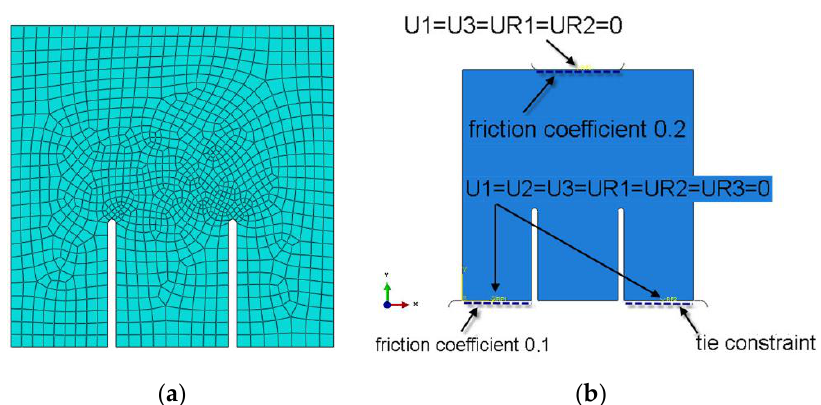
( b ) Figure 5. Specimen used in numerical analyses with ( a ) finite element mesh ( b ) boundary conditions: U—displacement, UR—rotation. In the course of the numerical analyses, it was found that the numerical results were convergent qualitatively and quantitatively with the experimental results [67,113]. The convergence of the results amounted to approximately 2%, which is clearly visible by comparing the exemplary charts of load ( F )–displacement ( f ) (Figure 6).